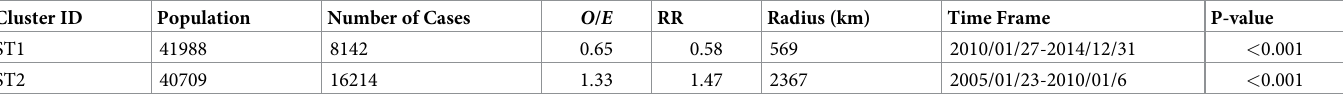
Table 4. Statistically significant clusters of high and low proportion of veterinary calls relative to public calls to the APCC detected from the space-time scan of the entire study period (2005–2014). Cluster ID